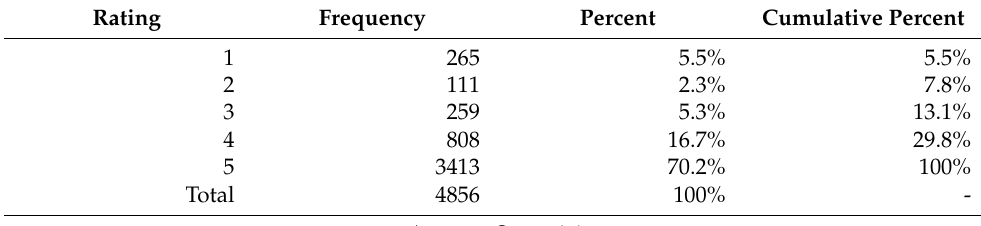
Table 2. Summarization of overall satisfaction rating.